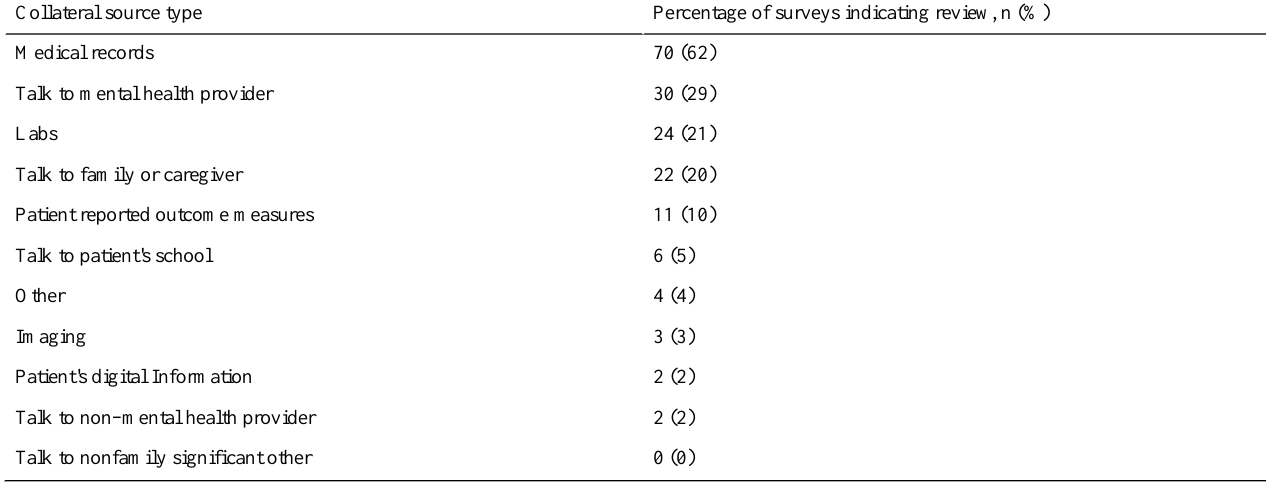
Table 2. Type of collateral source reviewed